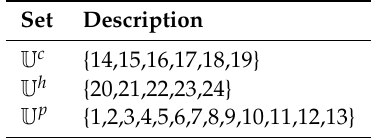
Table A7. Sets used test instance